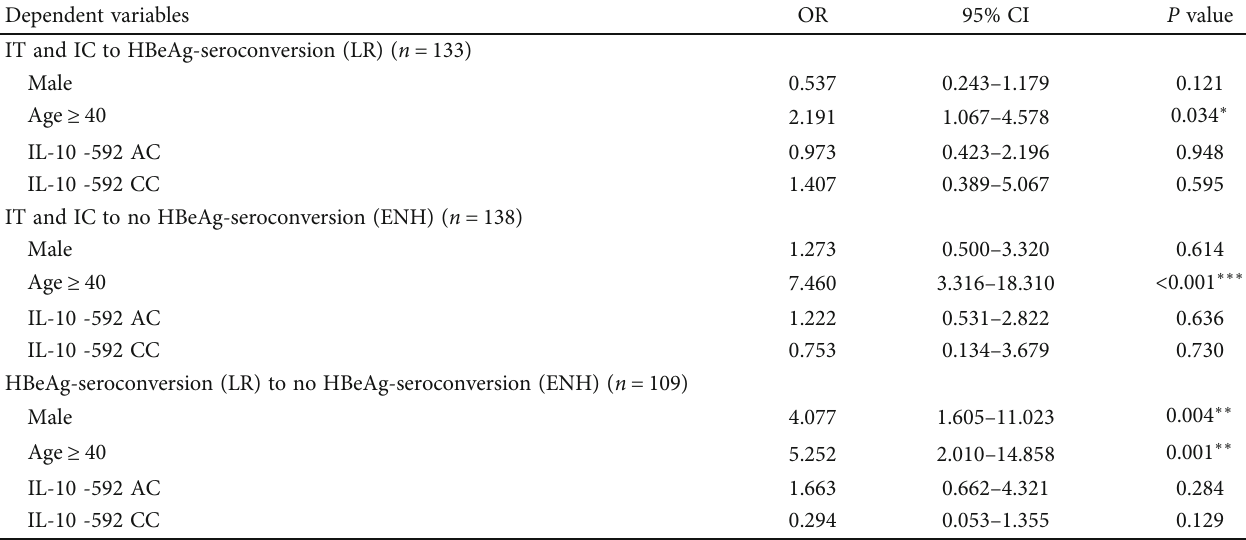
Table 4: Factors independently associated with the dynamics of chronic hepatitis B (CHB) determined using multivariate binomial logistic regression with backward elimination using Mendelian assumption.